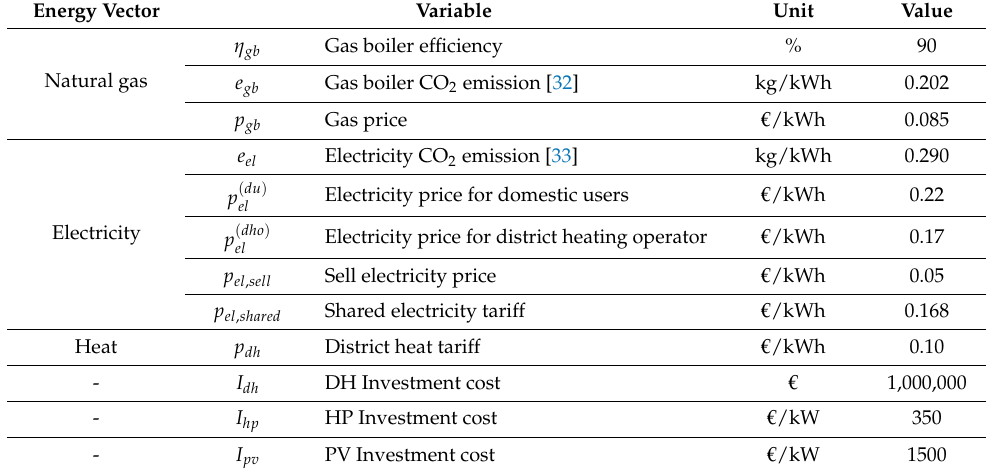
Table 3. Summary of economic assumptions.